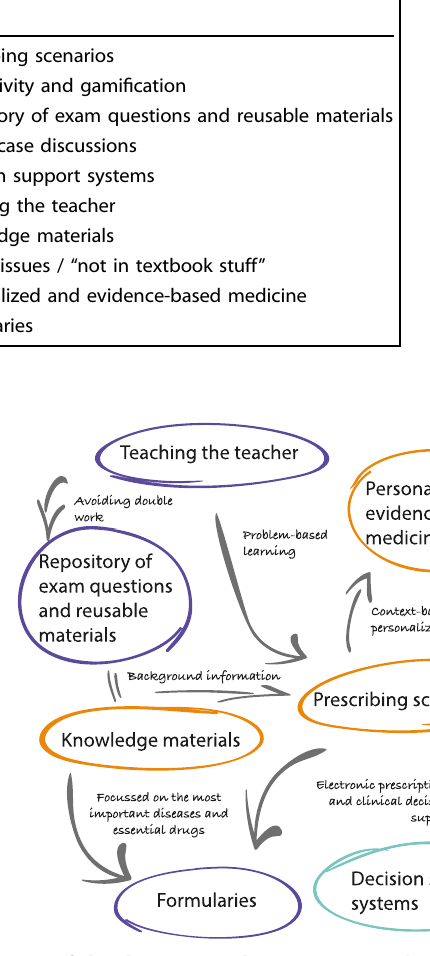
Fig. 1 Visual representation of the thematic analysis. Orange = related to learning outcomes for Clinical Pharmacology and Therapeutics; Cyan = related to format of teaching; purple = related to resource and faculty development. npj Science of Learning (2022)